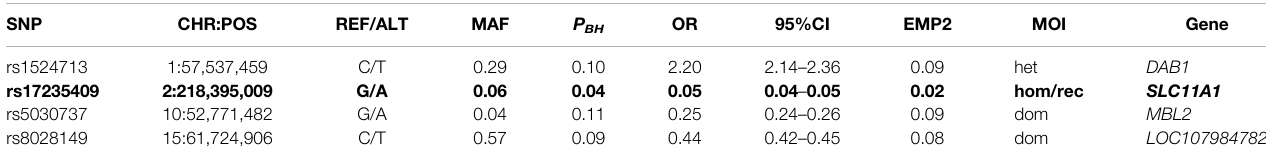
TABLE 4 | Association tests results for controls versus Mycobacterium tuberculosis sensu stricto (Mtbss)